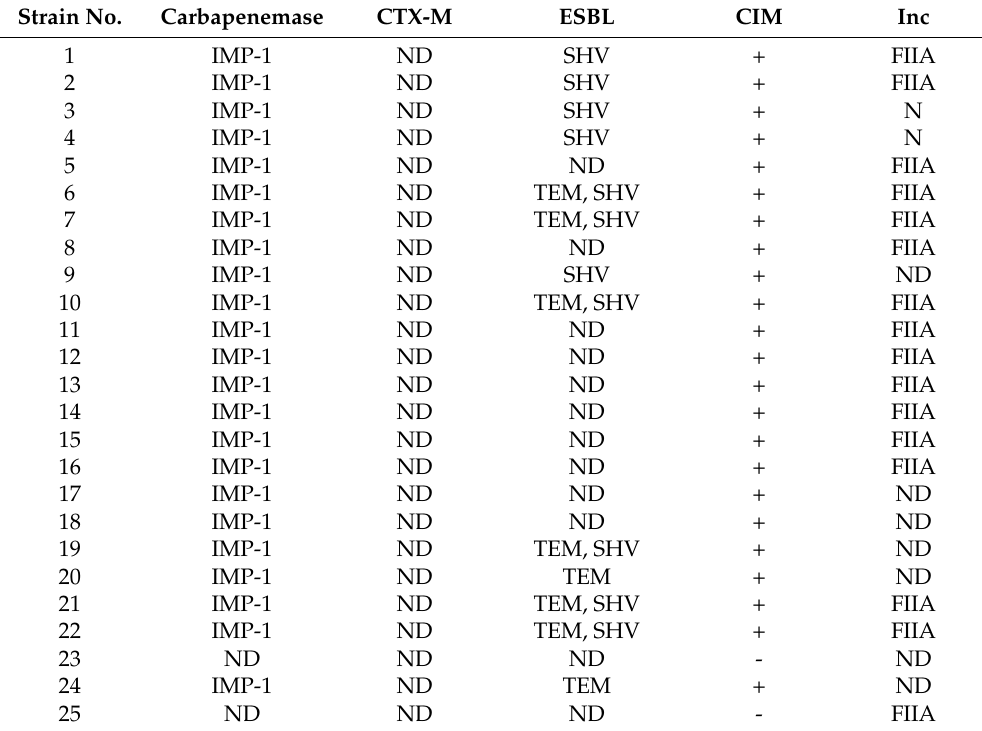
Table 2. Distribution of β -lactamase genes for 25 CRE isolates (22 from inpatients and 3 from environments). Twenty-three isolates were positive for CIM and all of the isolates harbored the IMP-1 β -lactamase gene. Two other CIM-negative isolates harbored no carbapenemase gene. Incompatibility group typing revealed two types of plasmids in the CPEs. Fifteen of the 23 CPE isolates possessed IncFIIA replicon regions, including K. pneumoniae ( n = 2), E. asburiae ( n = 11), and E. cloacae ( n = 2). Two other isolates belonged to IncN in K. pneumoniae , and the Inc type could not be determined for the six remaining